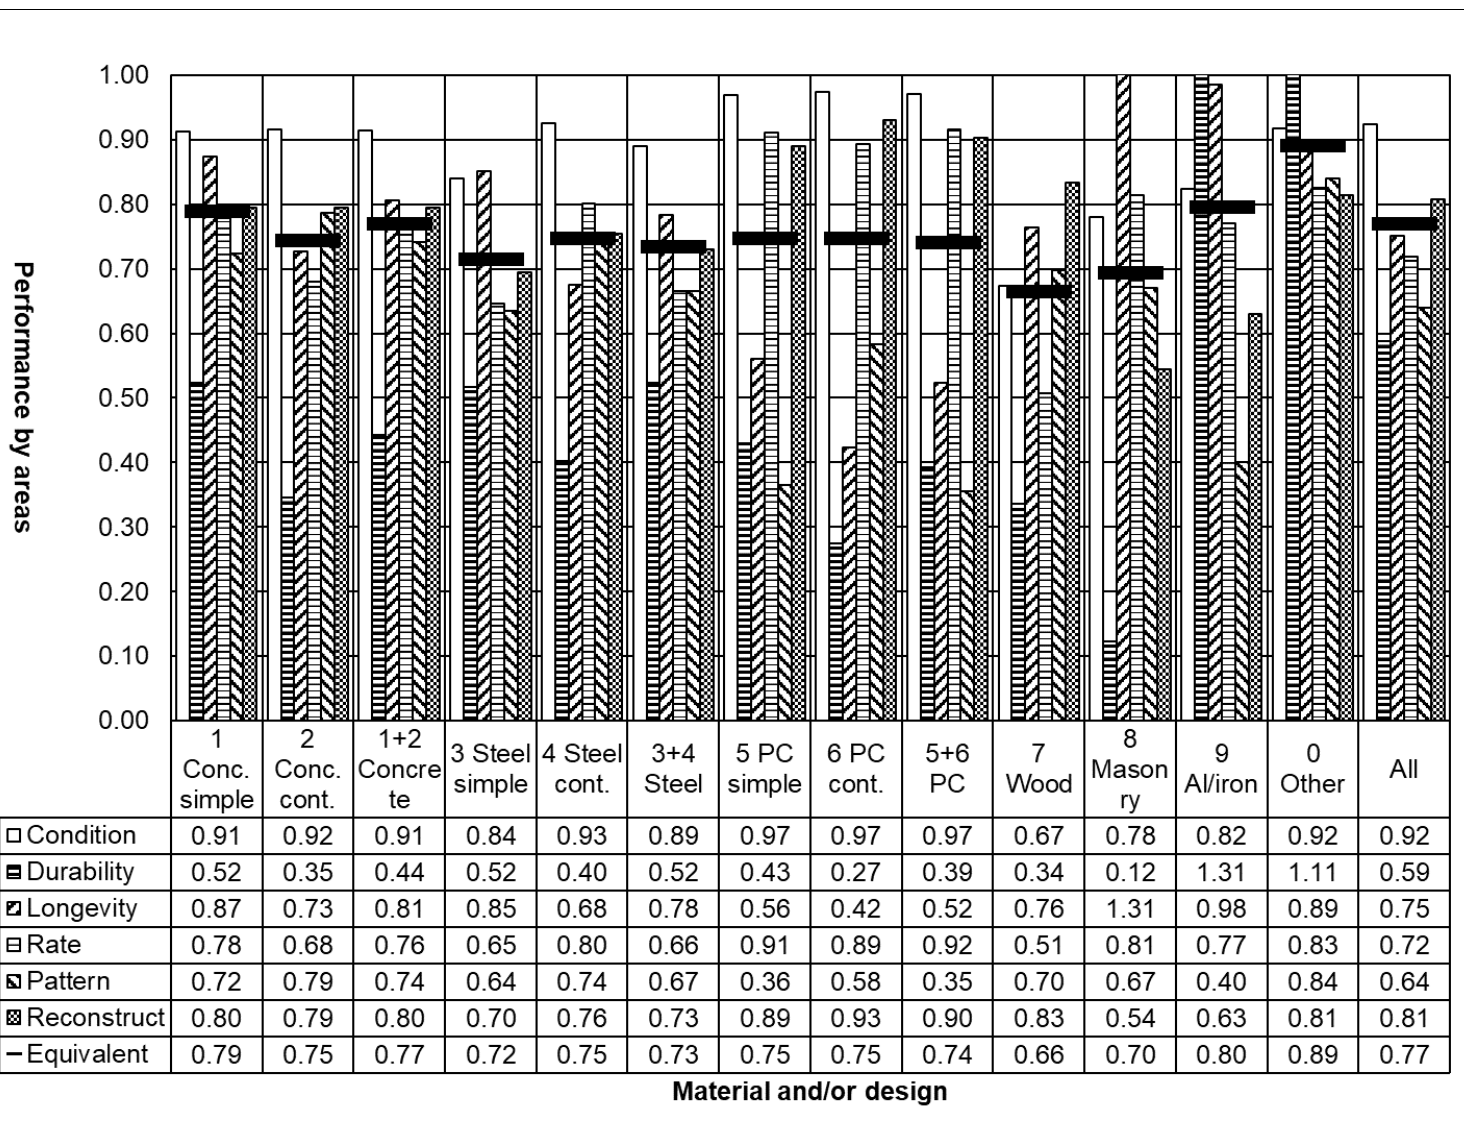
Figure 7. Comparison of structural performances of bridge areas by material and/or design.